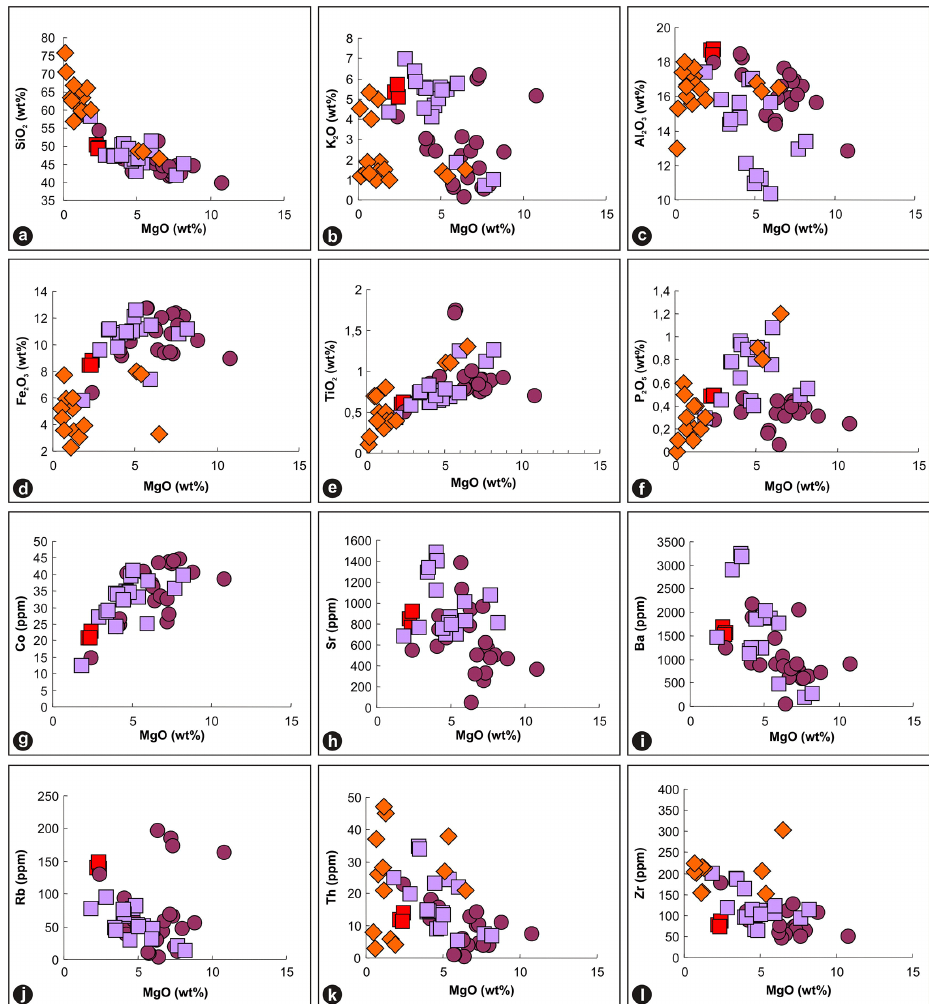
Fig. 15. Major oxides and trace elements vs. MgO variation diagrams for various alkaline island arc units.